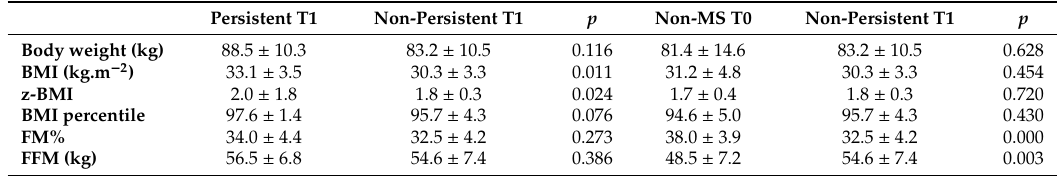
Table 2. Anthropometric and body composition results in persistent and non-persistent at T1 as well as among non-MS T0 and non-persistent T1.